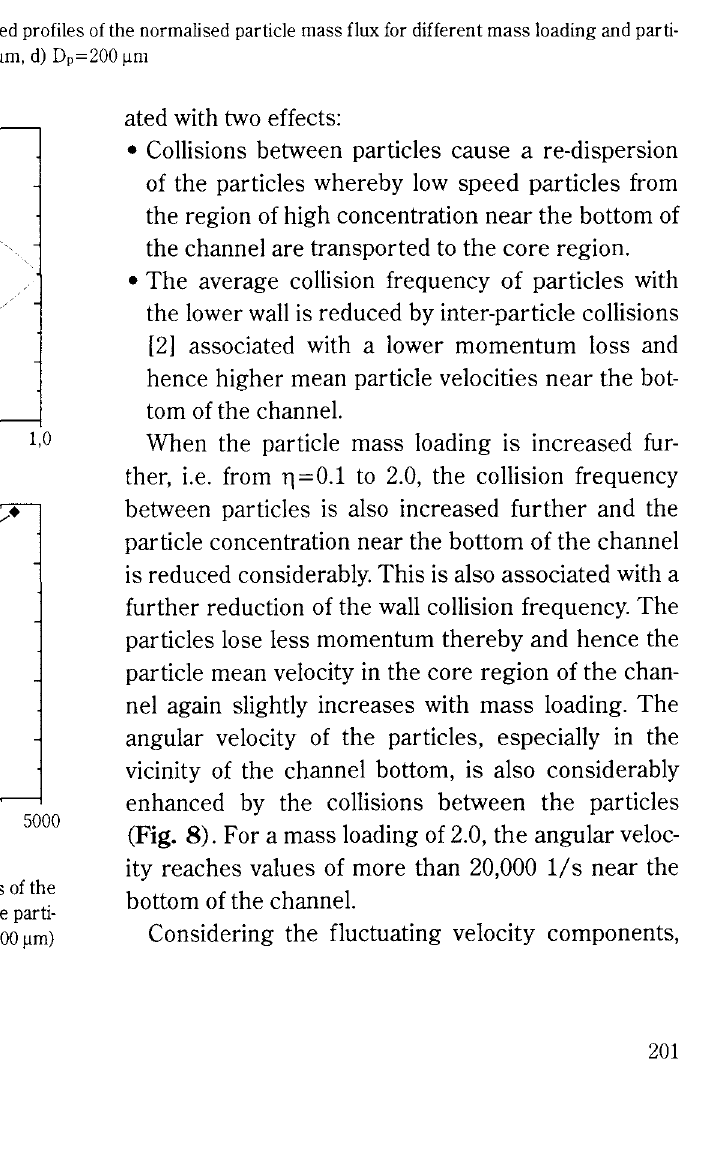
Influence of inter-particle collisions on the developed profiles of the normalised particle mass flux for different mass loading and parti cle sizes, a) Dp=25 ~m. b) Dp=50 ~m. c) Dp=100 ~m. d) Dp=200 ~m